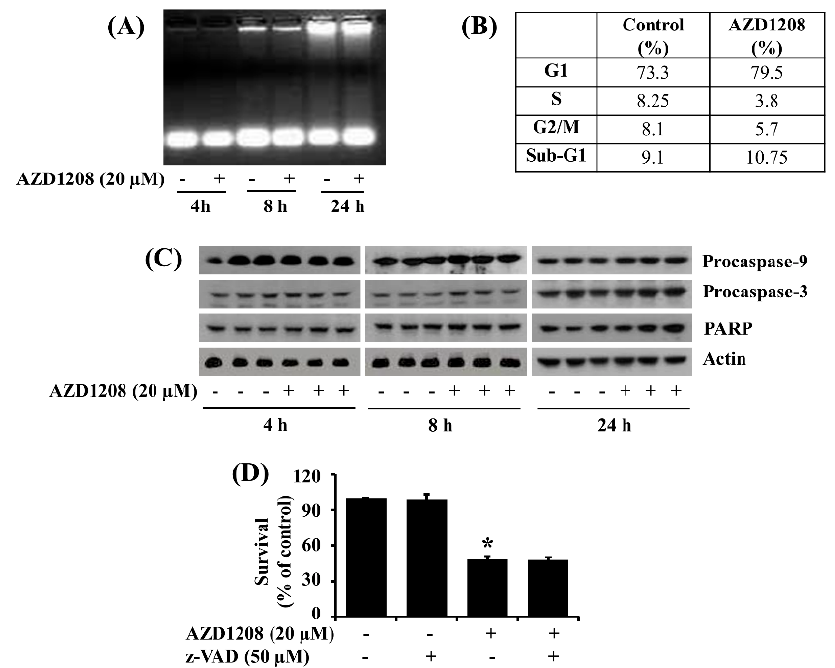
Figure 2. Effect of AZD1208 on apoptosis of 93T449 cells. ( A ) 93T449 cells were treated with AZD1208 (20 µM) or vehicle control (DMSO) for the times indicated. At each time point, extra-nuclear fragmented DNA from the conditioned cells was extracted and analyzed on a 1.7% agarose gel. The image is a representative of three independent experiments. ( B ) 93T449 cells were treated with AZD1208 (20 µM) or vehicle control (DMSO) for 24 h. The conditioned cells were harvested and subjected to fluorescence-activated cell sorting (FACS) analysis for measuring the population of sub G1 phase. The tables represent the fraction of apoptotic cells. ( C ) 93T449 cells were treated with AZD1208 (20 µM) or vehicle control (DMSO) in triplicate experiments for the times designated. At each time point, whole cell lysates were prepared and analyzed for procaspase-9, procaspase-3, PARP or β -actin expression or cleavage by Western blotting. ( D ) 93T449 cells were treated without or with AZD1208 (20 µM) in the absence or presence of the pan-caspase inhibitor z-VAD (50 µM) for 48 h, followed measurement of the number of surviving cells by cell count assay. The cell count assay was done in triplicate. Data are means ± SE of three independent experiments. * p < 0.05 compared to the control at the indicated time.